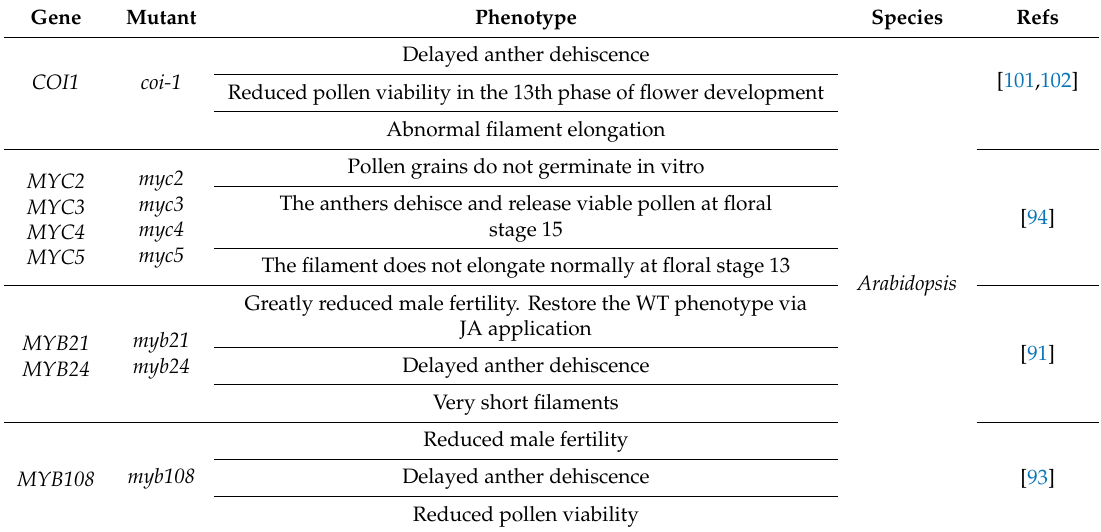
Table 4. Stamen-related features of JA responsive mutants. CORONATINE-INSENSITIVE1 (COI1); MYELOCYTOMATOSIS ONCOGENES